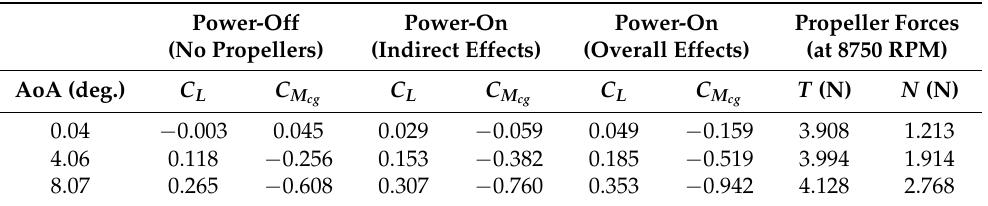
Figure 15. Indirect propulsive effect on the lift coefficient, Re = 315,000, X CG at LE MAC, IU rotation at two RPM settings. Table 7. Direct and indirect propeller effects breakdown, BHV aircraft configuration, Re = 315,000, X CG at LE MAC, 8750RPM